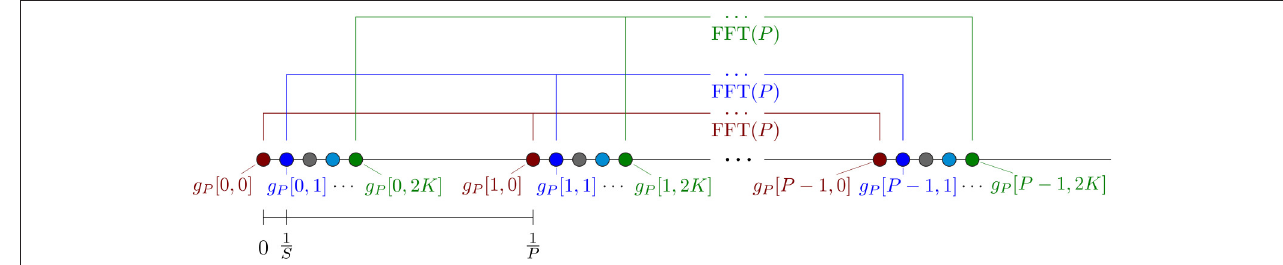
FIGURE 1 | Illustration of the sampling scheme (3.1) and the applied DFTs (3.2).